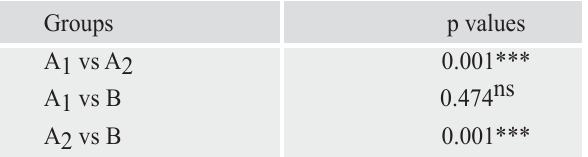
Table IIIB: Comparison of histological findings of liver between groups (n=33) Groups